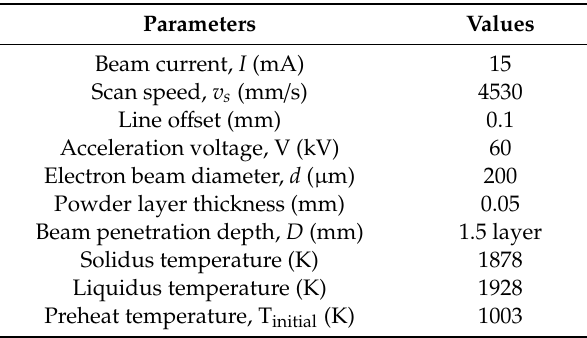
Table 1. Default EBM process parameters.